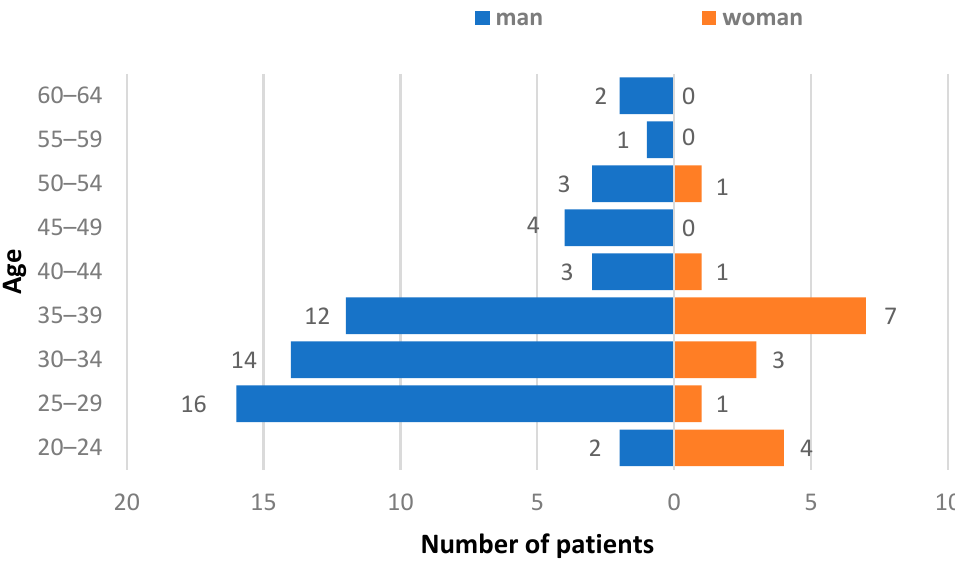
Figure 1. Gender and age structure of overall group. Table 1. HBV serological marker prevalence and distribution in the examined group (HBsAg, HBeAg, HBcore IgG, HBs IgG).